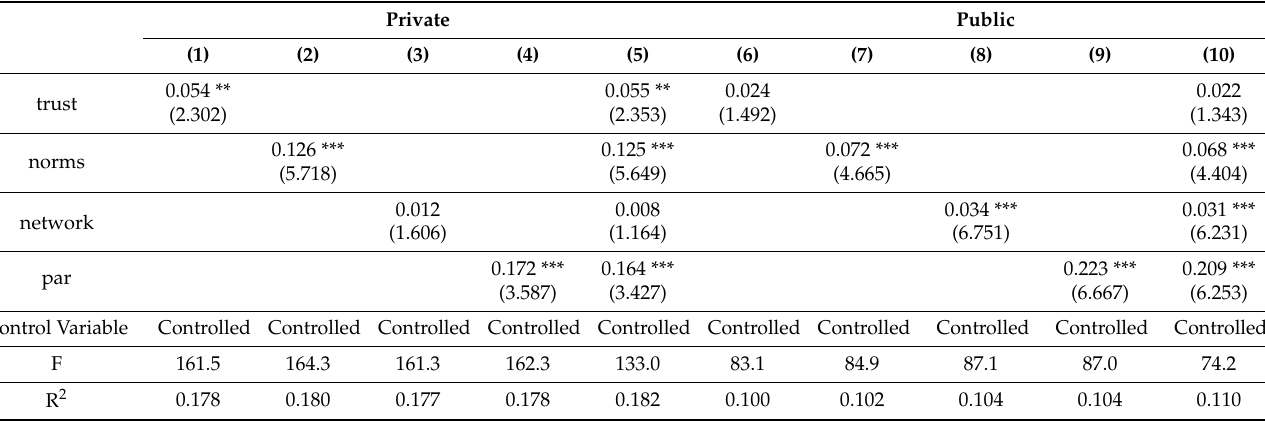
Table 5. Basic regression and robustness